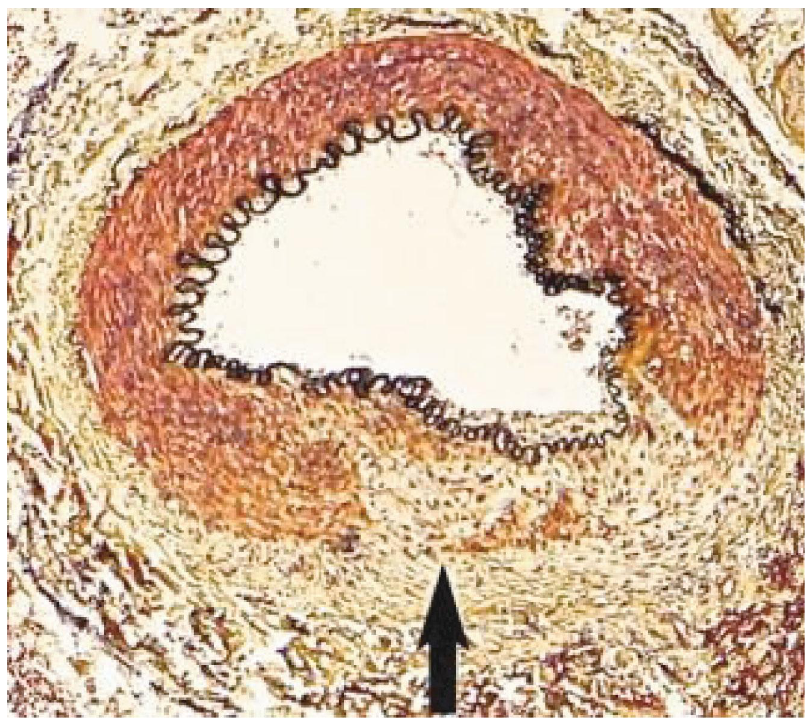
Figure 17: Segmental arterial mediolysis reparative phase. The arrow points to foci of reparative granulation tissue undergoing early fi brosis (yellow stain) in the media and in the adventitia appearing as a crescent that partially encircles the artery. The latter putatively represents an antecedent to adventitial fi bromuscular dysplasia. Movat stain × 100 (adapted with permission from Cardiovascular Pathology 18(6) copyright 2009, Elsevier